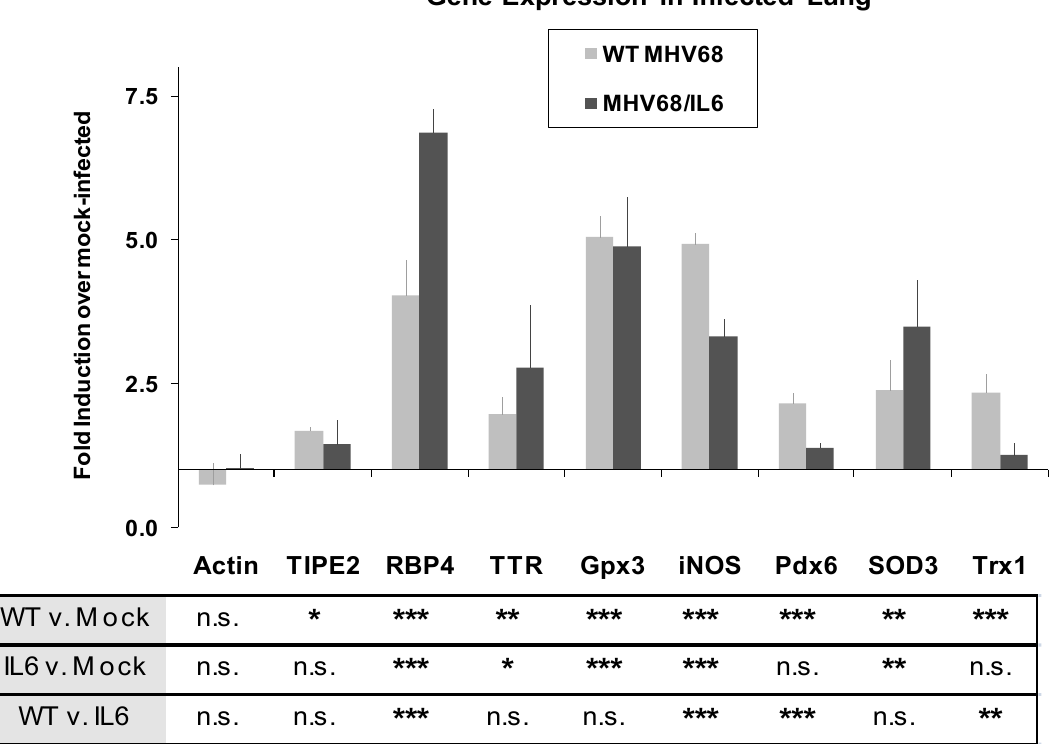
Figure 4. MHV-68 infection upregulates stress response genes in the lungs of infected mice. Mice were mock-infected, or infected i.n. with 2 × 10 5 pfu of WT MHV-68 or MHV68/IL6. Total lung RNA was isolated 7 d.p.i., and qRT-PCR performed with specific primers to murine acute phase, immunomodulatory, oxidative stress response genes, and actin. p -values of fold induction estimated from unpaired, 2-tailed t -test (sub-table) with p < 0.01 (***), p < 0.05 (**), p < 0.1 (*), or p > 0.1 (n.s., not significant). Error bars represent S.E.M. TIPE2 , Tnfaip8l2; Gpx3 , glutathione peroxidase 3; iNOS , inducible nitric oxide synthetase; SOD3, (extracellular) superoxide dismutase 3; Trx1, thioredoxin 1; RBP4, TTR, Pdx6 , as in Table S2.